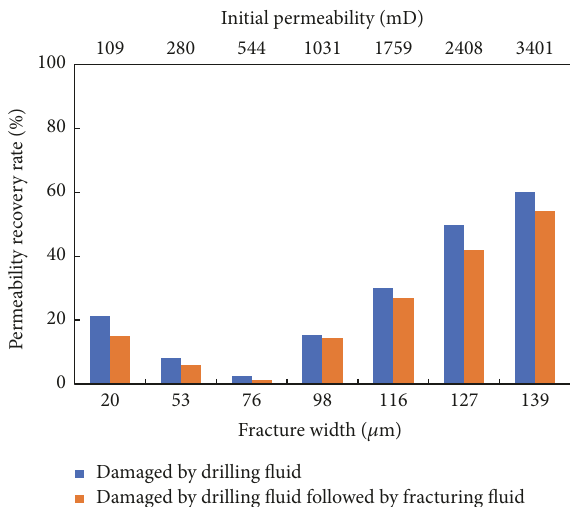
Figure 6: Change of effective permeability of fractured core with change of fracture width.